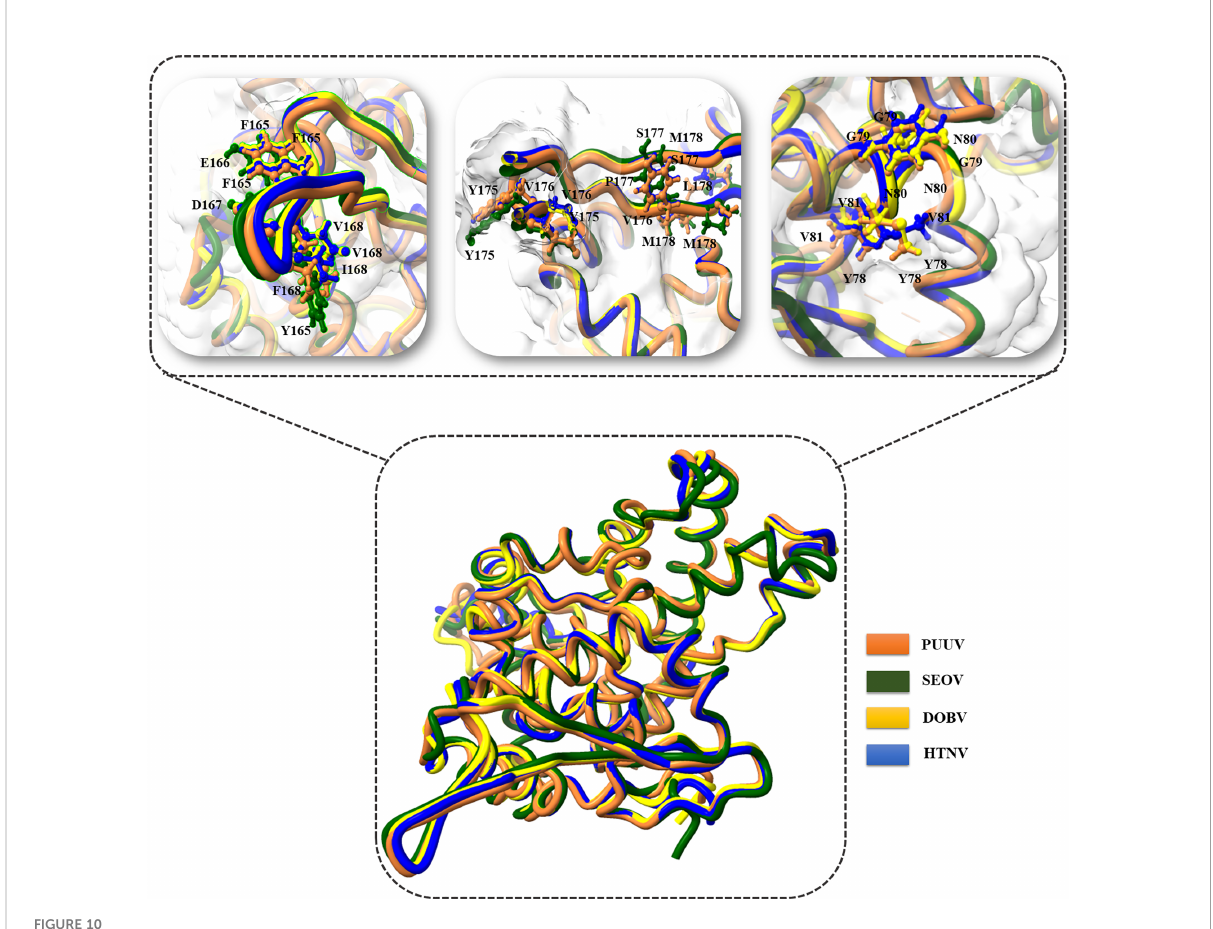
FIGURE 10 Superimposition of PUUV, SEOV, DOBV, and